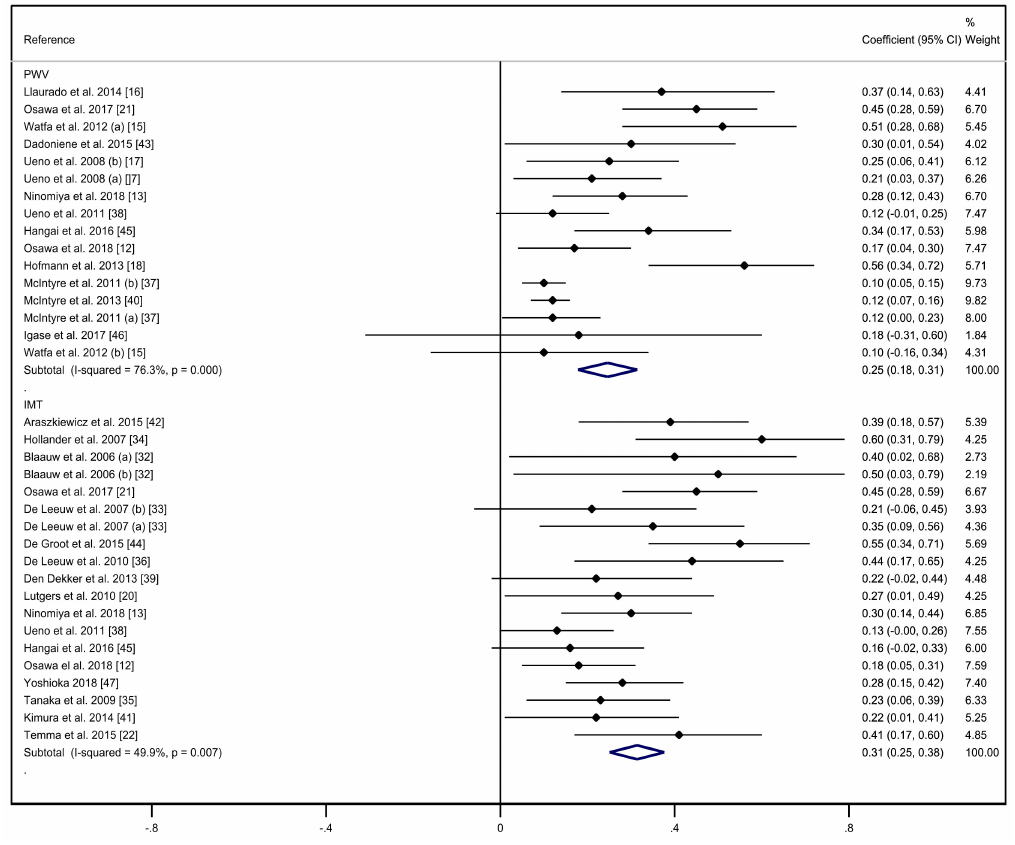
Figure 2. Forest plot including correlation between pulse wave velocity or carotid intima media thickness and skin